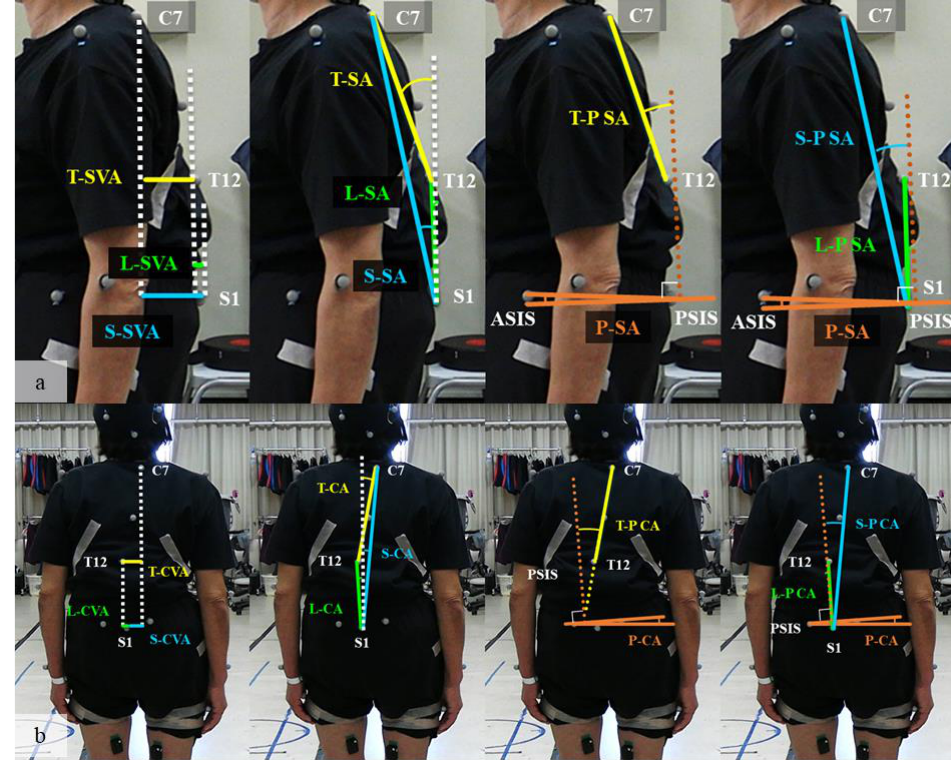
Figure 2. ( a ) Sagittal parameters: the dotted white line indicates a perpendicular line to the floor. The dotted brown line indicates the perpendicular line to the surface created from the two ASIS and two PSIS points (pelvic surface). SVA was defined by the sagittal distance between C7 – T12 (T – SVA), T12 – S1 (L – SVA), and C7 – S1(S – SVA). SA was defined by the sagittal angle of C7 – T12 line (T-SA), T12 – S1 line (L-SA), and C7 – S1 line (S-SA) from the perpendicular line. PSA was defined by the sagittal angle between the floor and the pelvic surface. T-PSA, L-PSA, and S-PSA were defined by the sagittal angle of C7 – T12 line (T-P SA), T12 – S1 line (L-P SA), and C7 – S1 line (S-P SA) from the perpendicular line to the pelvic surface; ( b ) coronal parameters: the dotted white line indicates a perpendicular line to the floor. The dotted brown line indicates the perpendicular line to the surface created from the two ASIS and two PSIS points (pelvic surface). CVA was defined by the coronal distance between C7 – T12 (T-CVA), T12 – S1 (L-CVA), and C7 – S1 (S-CVA). CA was defined by the coronal angle of C7 – T12 line (T-CA), T12 – S1 line (L-CA), and C7 – S1 line (S-CA) from the perpen- dicular line. PCA was defined by the coronal angle between the floor and the pelvic surface. T-P CA, L-P CA, and S-P CA were defined by the sagittal angle of C7 – T12 line (T-P SA), T12 – S1 line (L- P SA), and C7 – S1 line (S-P SA) from the perpendicular line to the pelvic surface. (T), thoracic; (L),